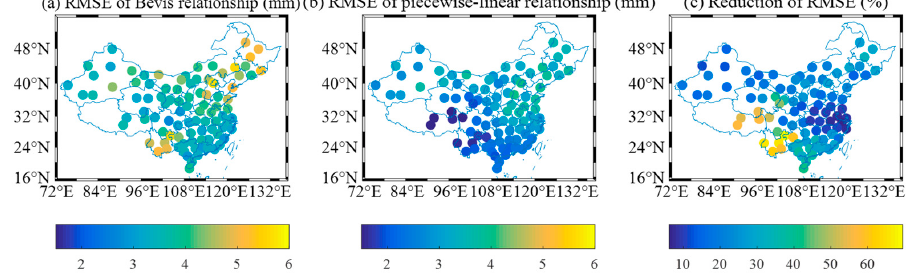
Figure 6. RMSE (K) distribution of the T m calculated by the site-specific piecewise-linear relationship ( a ), Bevis T m - T s relationship ( b ), and reduction of the RMSE (%) by the site-specific piecewise-linear T m - T s relationship ( c ).